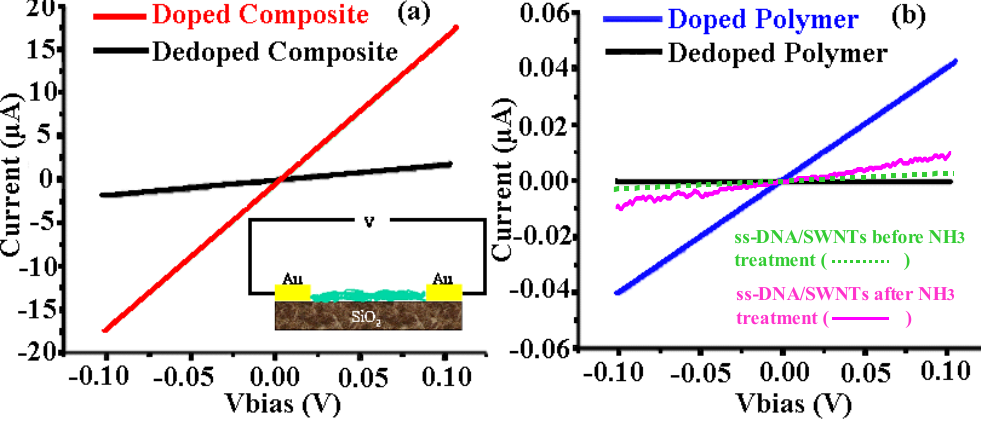
Figure 2. Typical I-V characteristic curves of the (a) PABA-ss-DNA/SWNTs composite film, (b) PABA alone, and ss-DNA/SWNT alone before and after treatment with NH (Reproduced with permission from the American Chemical Society